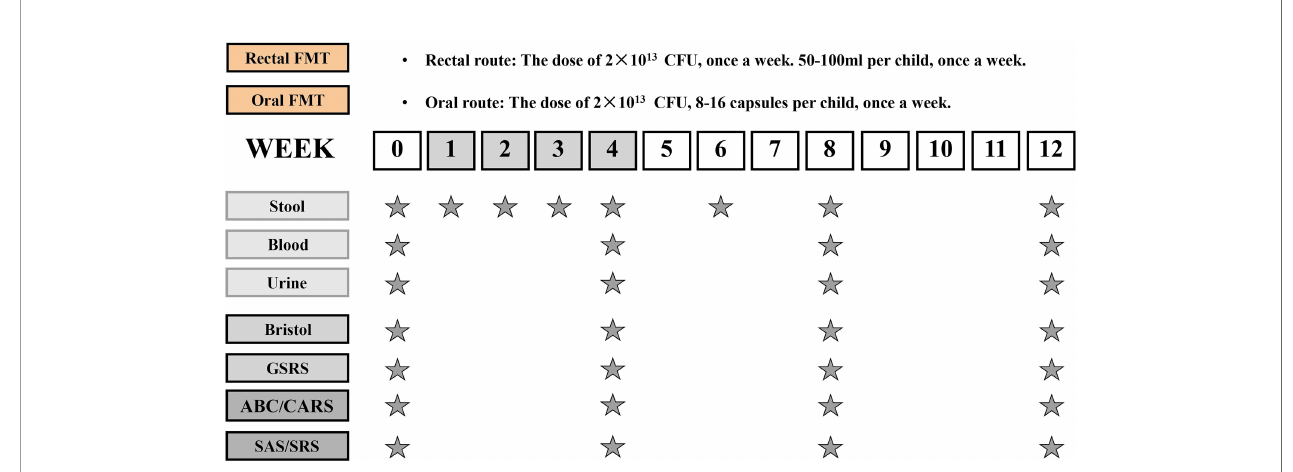
FIGURE 1 | Study design timeline. The trial consisted of a 4-week period of FMT and an 8-week follow-up observation period after the end of treatment. The time schedule of sample collection and GI/behavioral assessments.